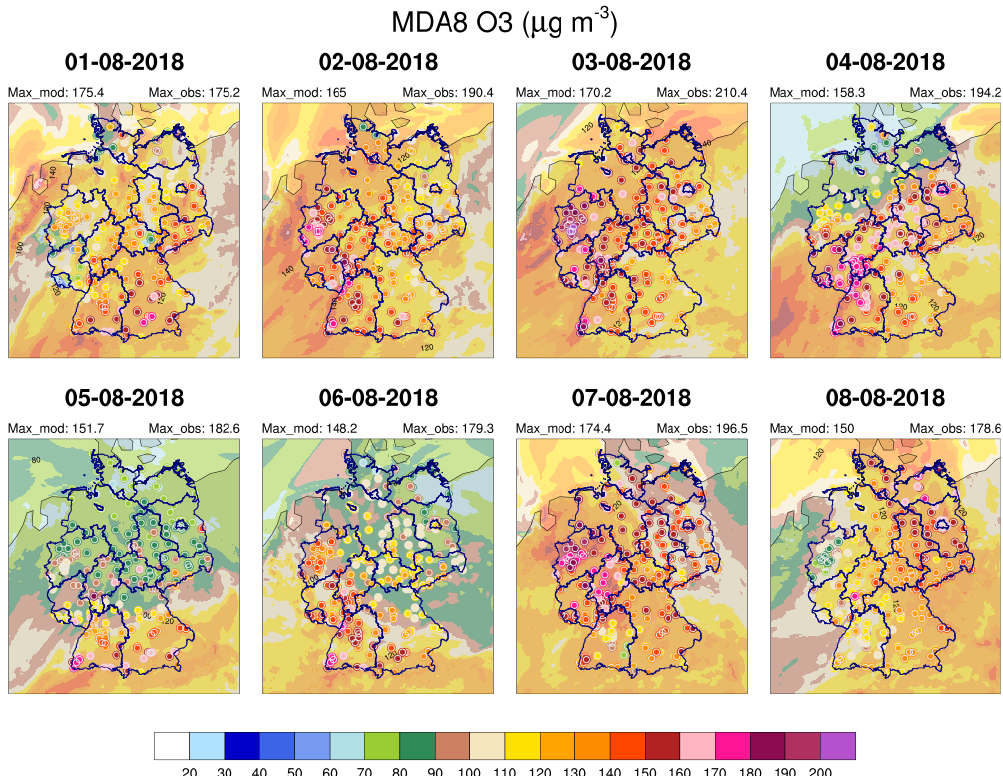
Figure 3. Daily surface MDA8 O 3 (µgm − 3 ) for the 1–8 August 2018 period. Colored dots represent the observed MDA8 O 3 concentrations at the German background